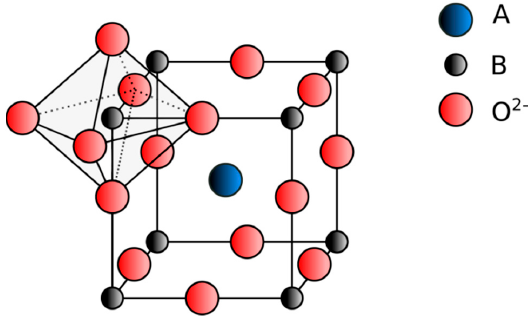
Figure 3. Ideal cubic perovskite structure with an octahedral site.